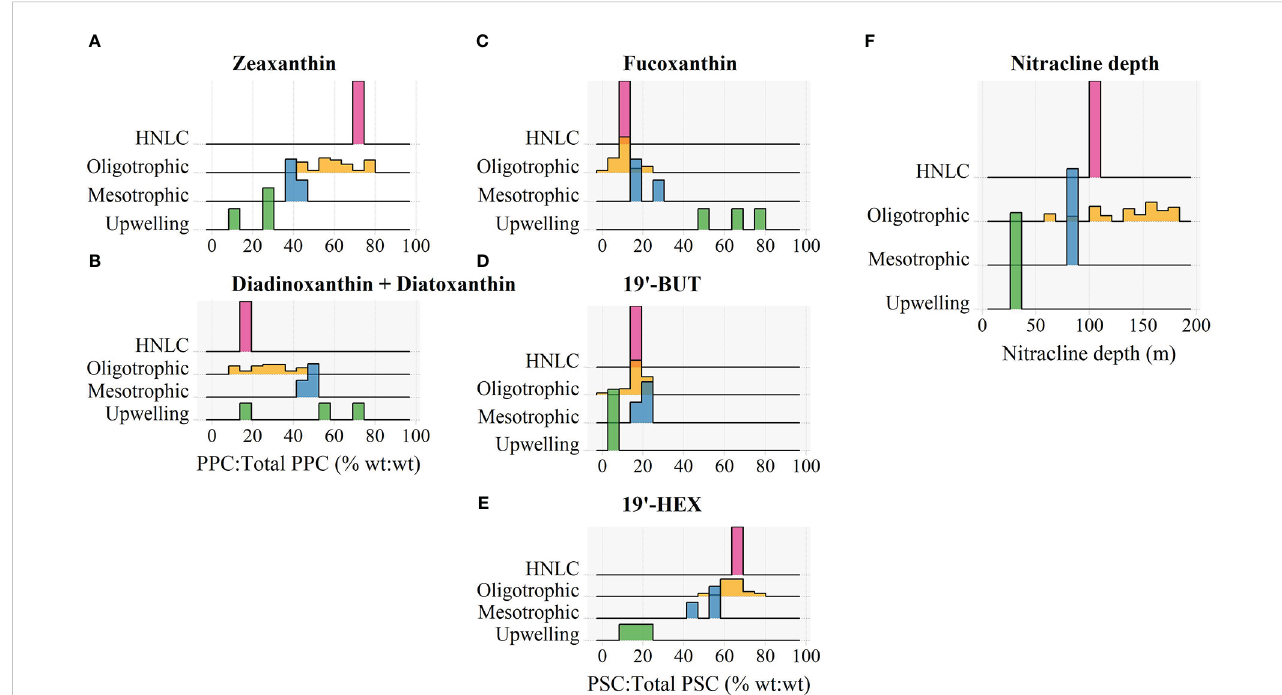
FIGURE 2 Frequency distributions of the percent contribution of (A) zeaxanthin and (B) diadinoxanthin + diatoxanthin to the total concentration of photoprotective carotenoids (PPC), and the percent contribution of (C) fucoxanthin, (D) 19 ’ -butanoyloxyfucoxanthin (19 ’ -BUT), and (E) 19 ’ -hexanoyloxyfucoxanthin (19 ’ - HEX) to the total concentration of photosynthetic carotenoids (PSC), and (F) the estimated nitracline depth for different trophic domains encountered during the BIOSOPE transect. Pigment contributions were measured in surface waters where z / z e <